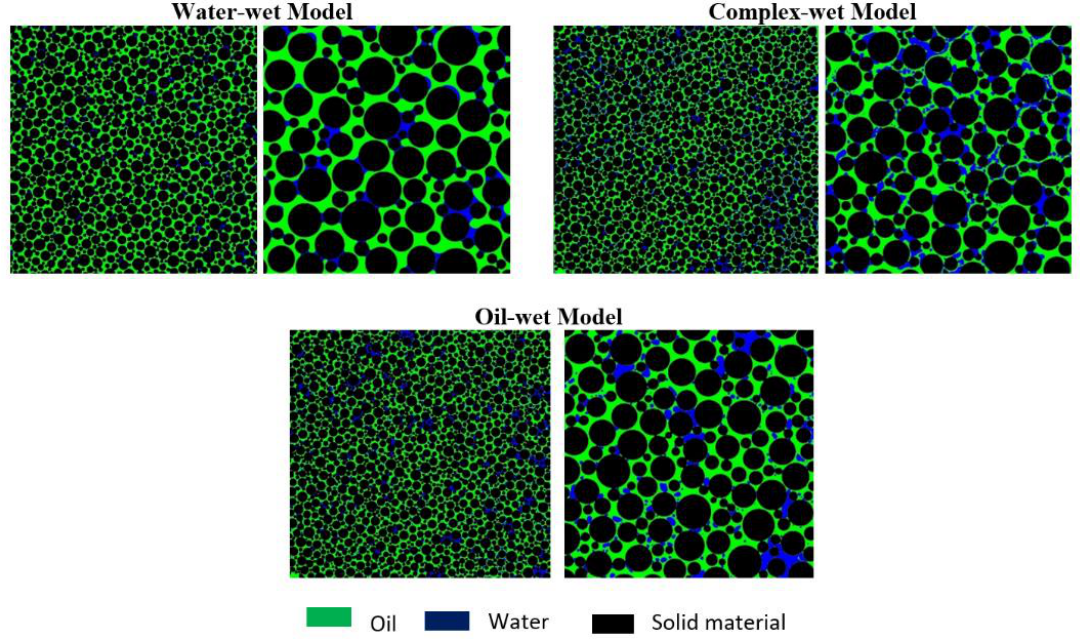
Figure 7. Micromodel with different wettability conditions. Left—Each wettability condition represents the micromodel (scale of 46mm*46mm); Right—Zoomed image of the bottom right corner for each micromodel (scale of 12mm*12mm).